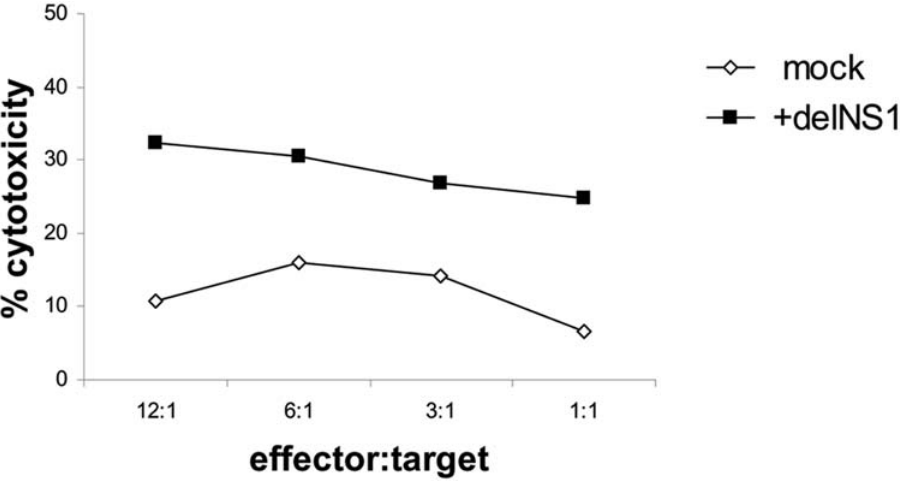
Figure 4. Induction of an anti-tumor cytotoxic immune response by virus infected splenocytes from BALB/c mice against a syngeneic tumor. Splenocytes were mock-treated or infected with delNS1 virus (m.o.i.=0.02) and incubated for 24 hours. Then splenocytes were co-cultured with the target C-26 cells for 24 hours and cytotoxicity was assessed thereafter. One representative result in percentage of cytotoxicity is shown from three independent experiments.